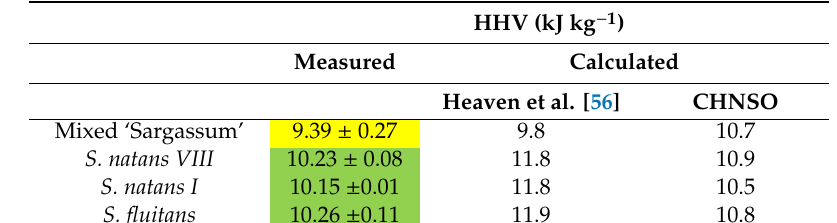
Table 10. The mean Higher Heating Values (HHVs) and standard deviation ( n = 3) from the bomb calorimetry of Sargassum inundation (‘Mixed Sargassum’) and pelagic species of Sargassum from Turks and Caicos, together with calculated HHVs from CHNSO or protein, lipid and carbohydrate content (Heaven et al. [56]). Di ff erences in colour within a column indicate statistically significant di ff erences between samples ( p < 0.05).